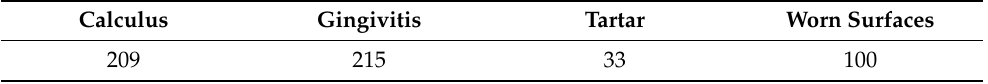
Table 1. The number of times that various lesions appear on the collected images.